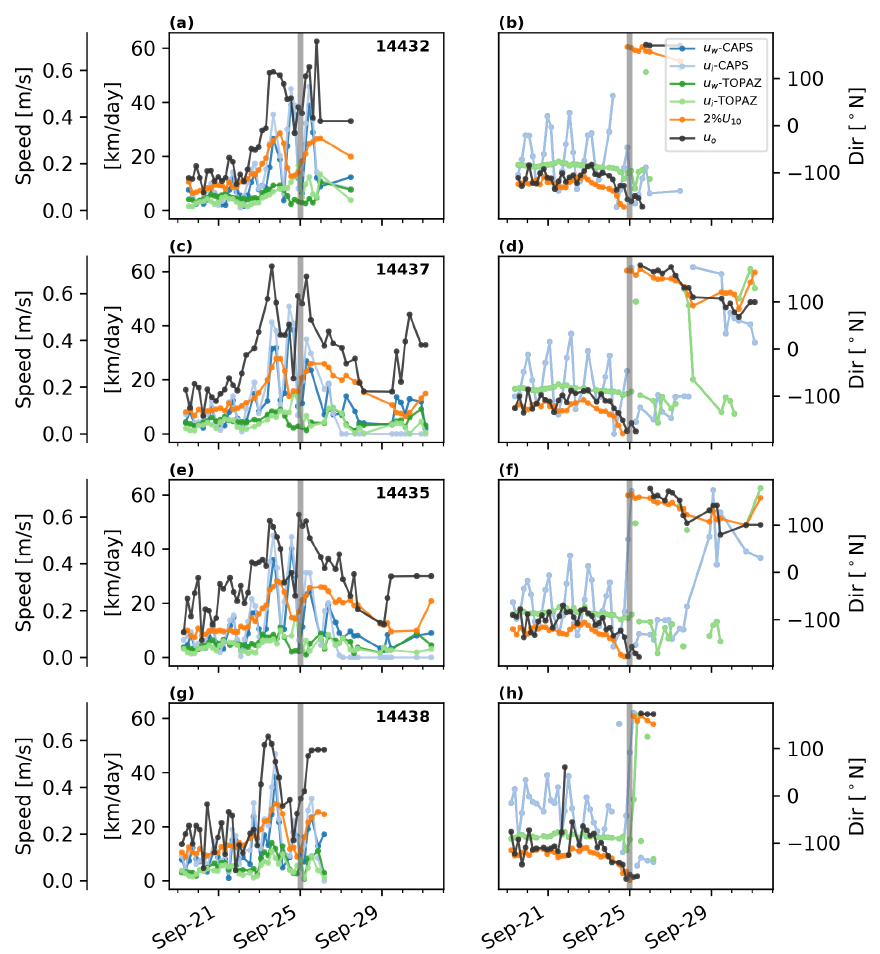
Figure 3. Magnitude and direction of observed drifter velocities ( u o , black) and predicted wind velocity (2%; U 10 , orange), as well as ice ( u i ) and water velocities ( u w ), from CAPS (blue) and TOPAZ (green) interpolated to the drifter locations. The strong diurnal tidal current is clearly observed in CAPS but is absent from TOPAZ as this model does not include tides. The vertical grey line shows the approximate time when the drifters exit the